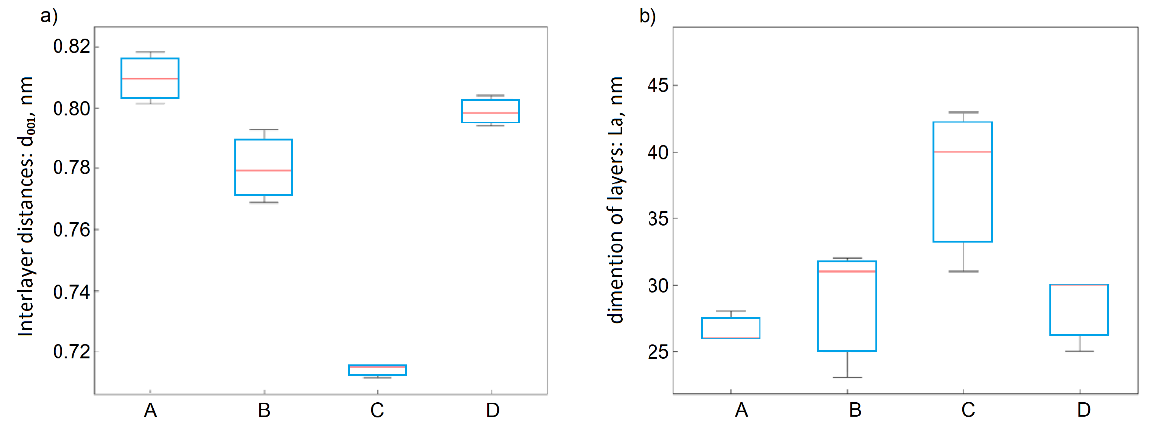
Figure 3. Box plots for ( a ) d 001 and ( b ) L a as functions of the applied method. The deconvolution of XPS C1s spectra of graphite oxides showed that oxygen oc- curred mainly (i.e., more than 50% of the total oxygen content) in the epoxy and hydroxyl connections located on the graphite planes (at the edges there were fewer carbonyl and quinone or carboxylic groups). The total amounts of carbon with sp 2 hybridization varied to a great extent in the graphite oxides (37–6%), which depended on the oxidation methods (Figure 4a) in a significant way. The carbon content with sp 2 hybridization was inversely proportional to the oxidation yield, as shown in Figure 4b. The carbon content with this hybridization method increased when the degree of oxidation decreased and had the following trend: method C < method B < method